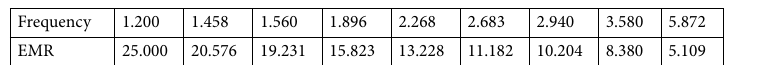
Table 4. EMR values of proposed MSM design at all resonance